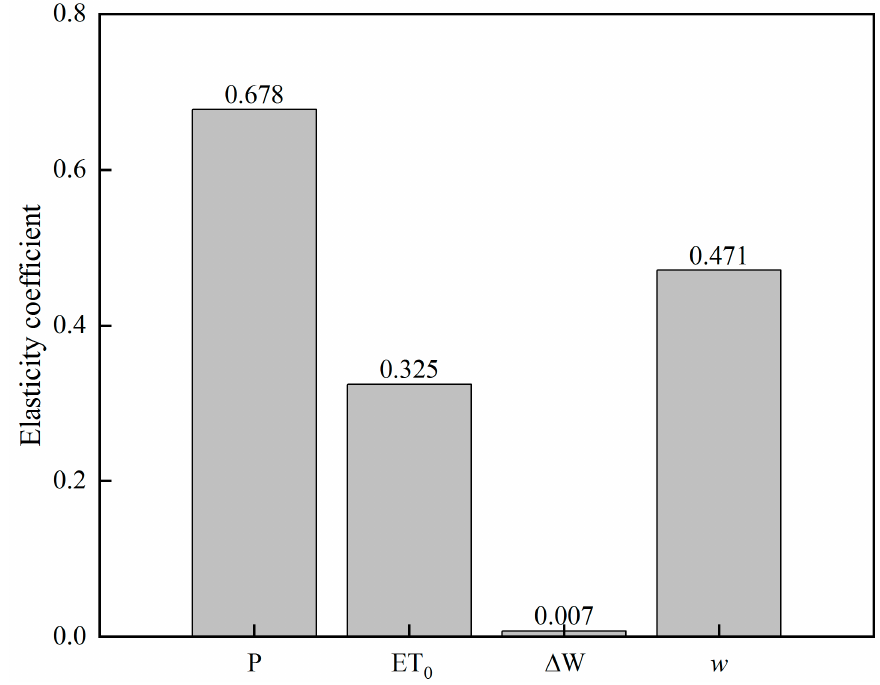
Figure 4. Elasticity coefficients of ET to P, ET 0 , ∆ W, and w .